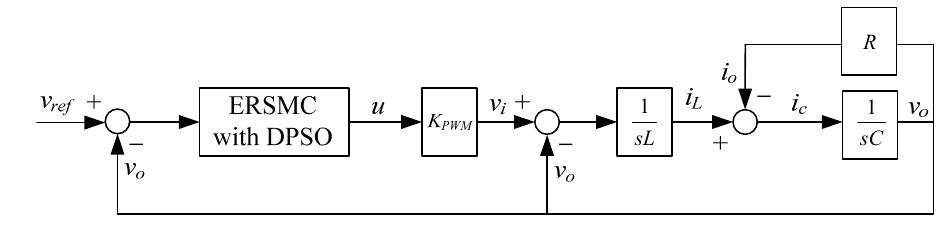
Figure 3. Block diagram of the PWM voltage source inverter with the proposed controller.